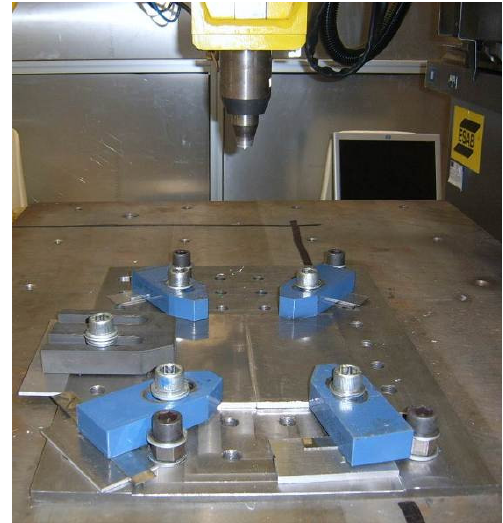
Figure 2. Positioning of the work piece on the fixture table.